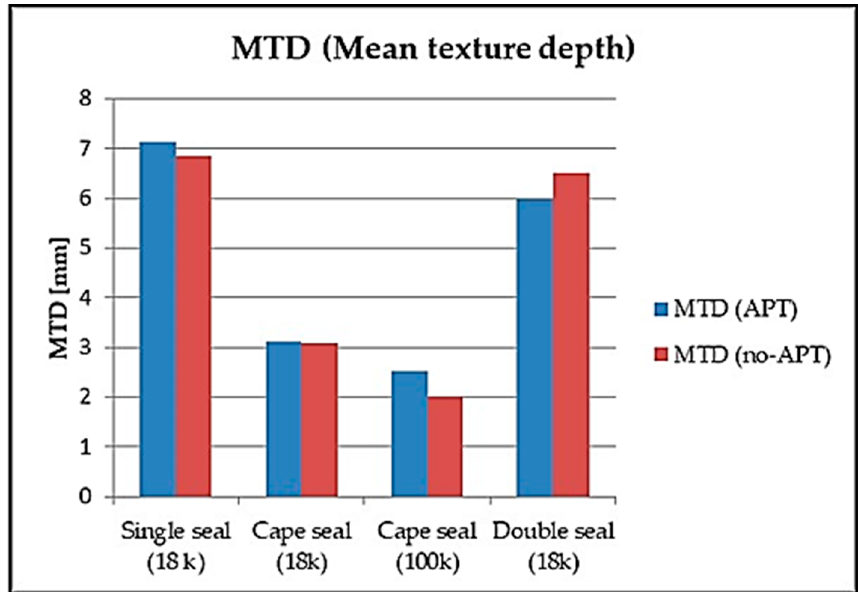
Figure 22. Comparative Mean Texture Depth (MTD) between the various chip seal surfacings both with and without APT loading.